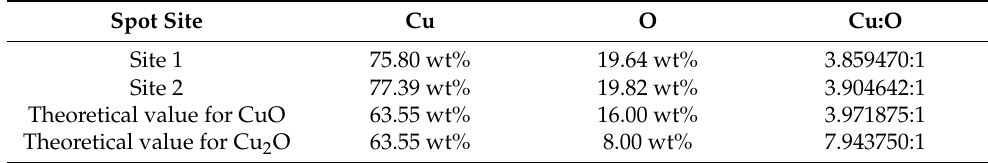
Table 3. The elemental compositions of surface species for CuO-600.